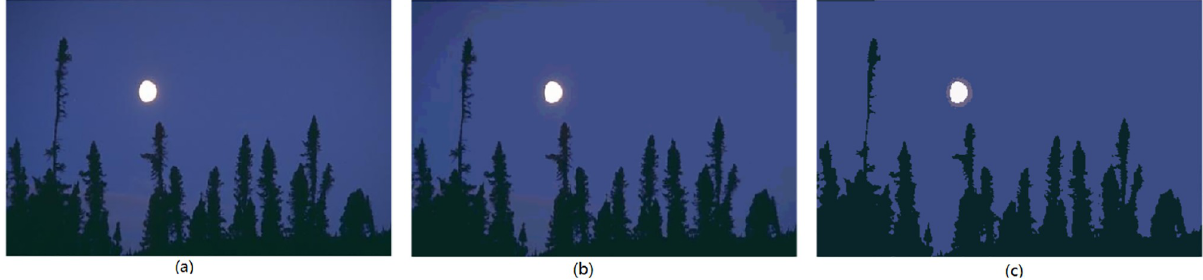
Fig 3. The image Moon: (a) original image, (b) initial segmented result (225 colors), (c) final segmented result (4 colors).